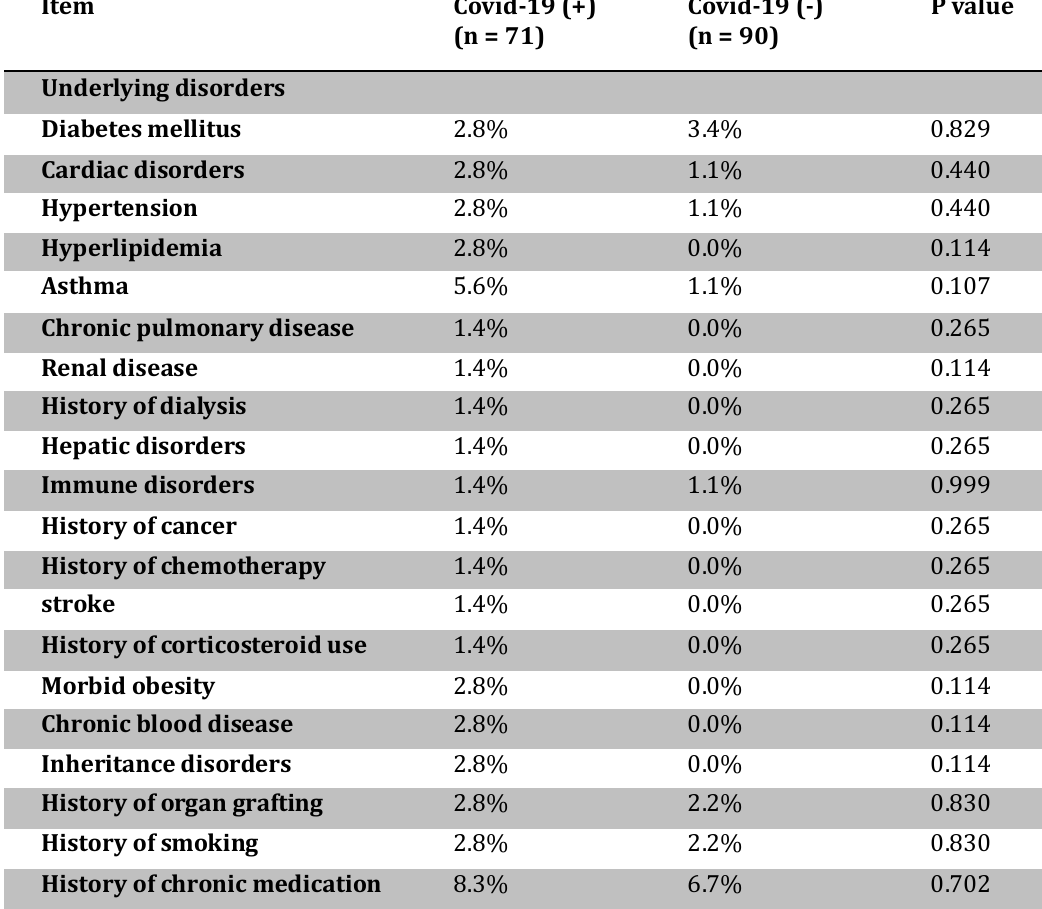
Table 3 : Underlying disorders among personnel with and without Covid-19